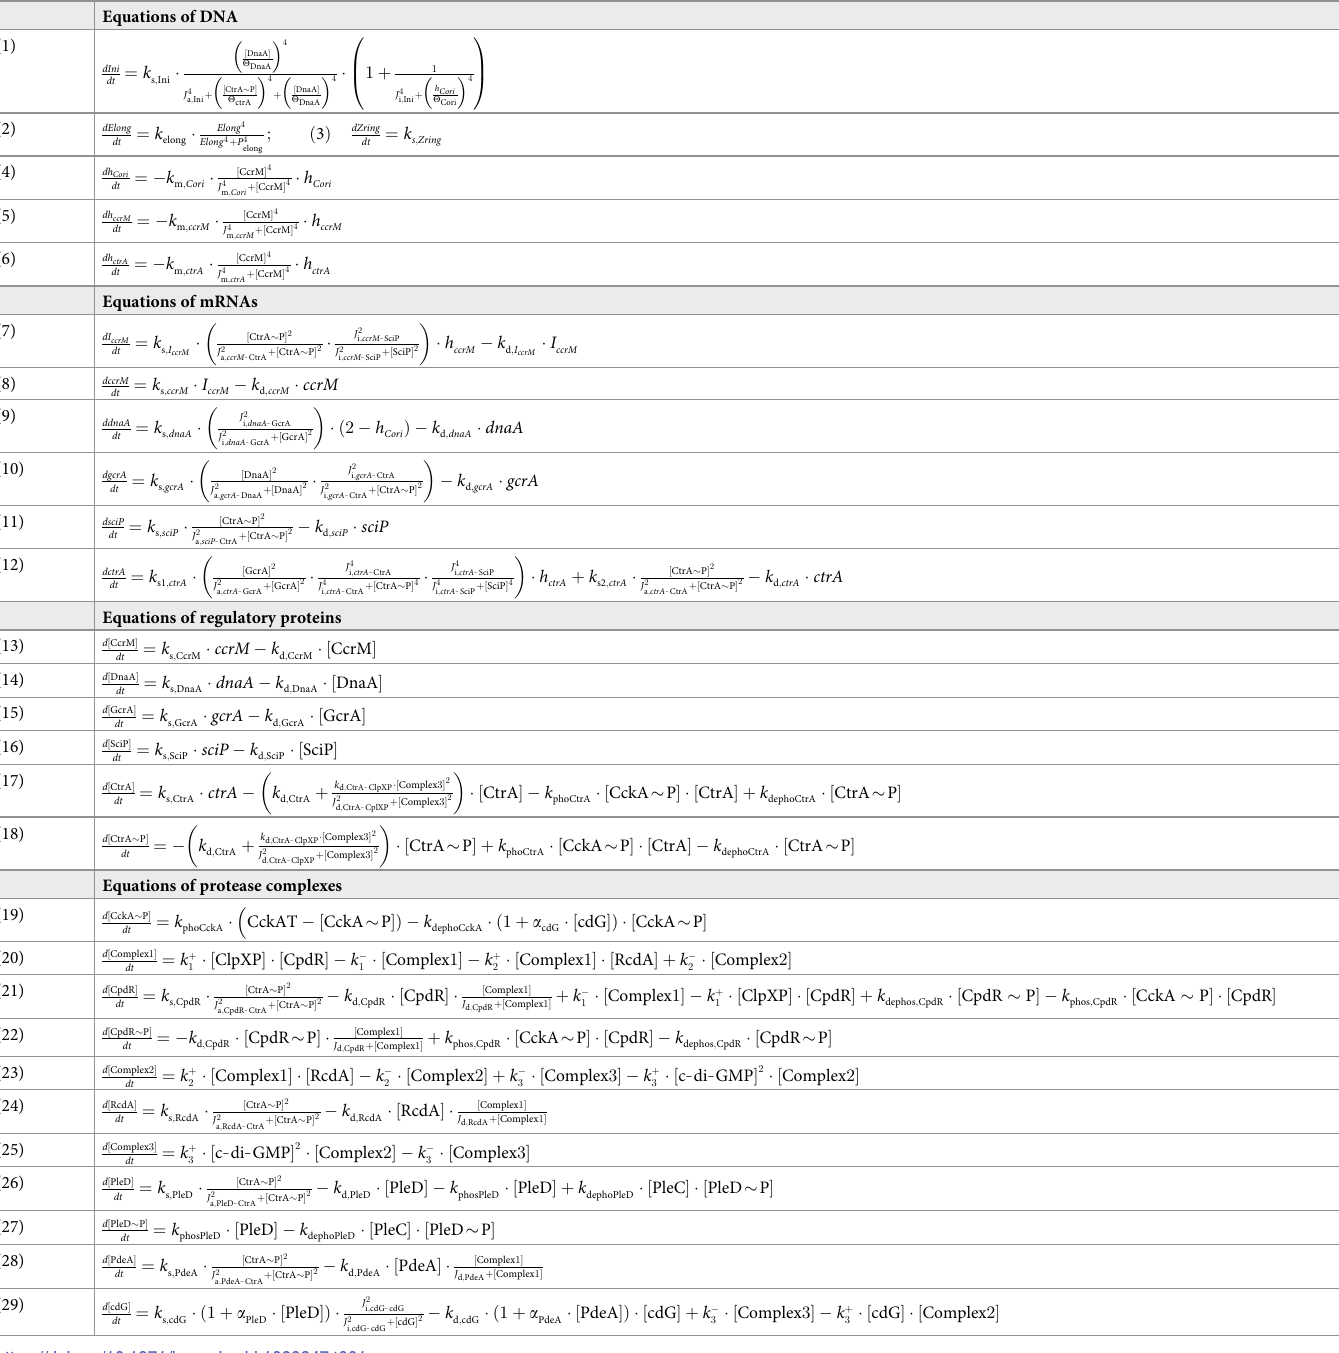
Table 1. Equations of replication and methylation, transcription, translation, and proteolysis. Equations of